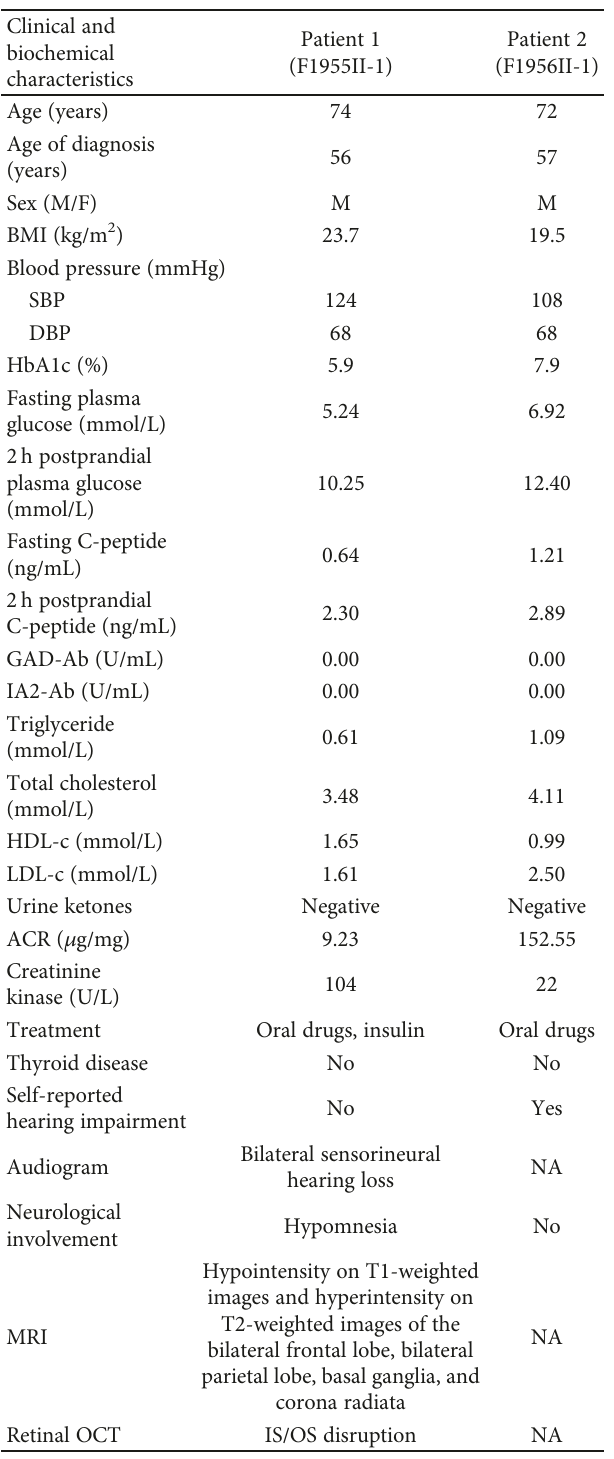
Table 1: The clinical characteristics of patients with type 2 diabetes. Clinical characteristics